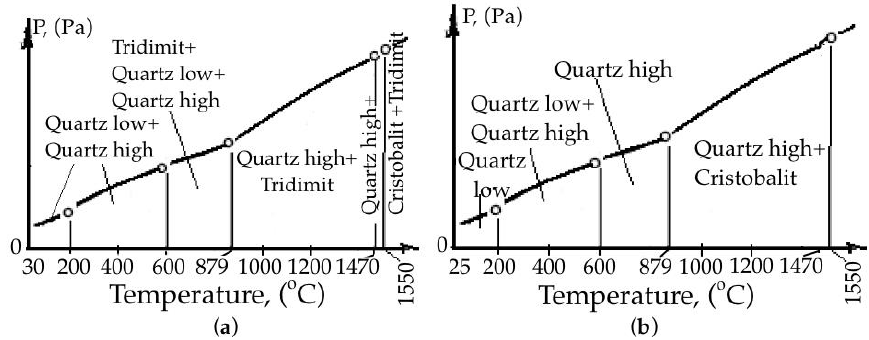
Figure 9. Phase transformations in quartzite during its heating: ( a ) heat treatment at 800 °C; ( b ) heat treatment at 200 °C.